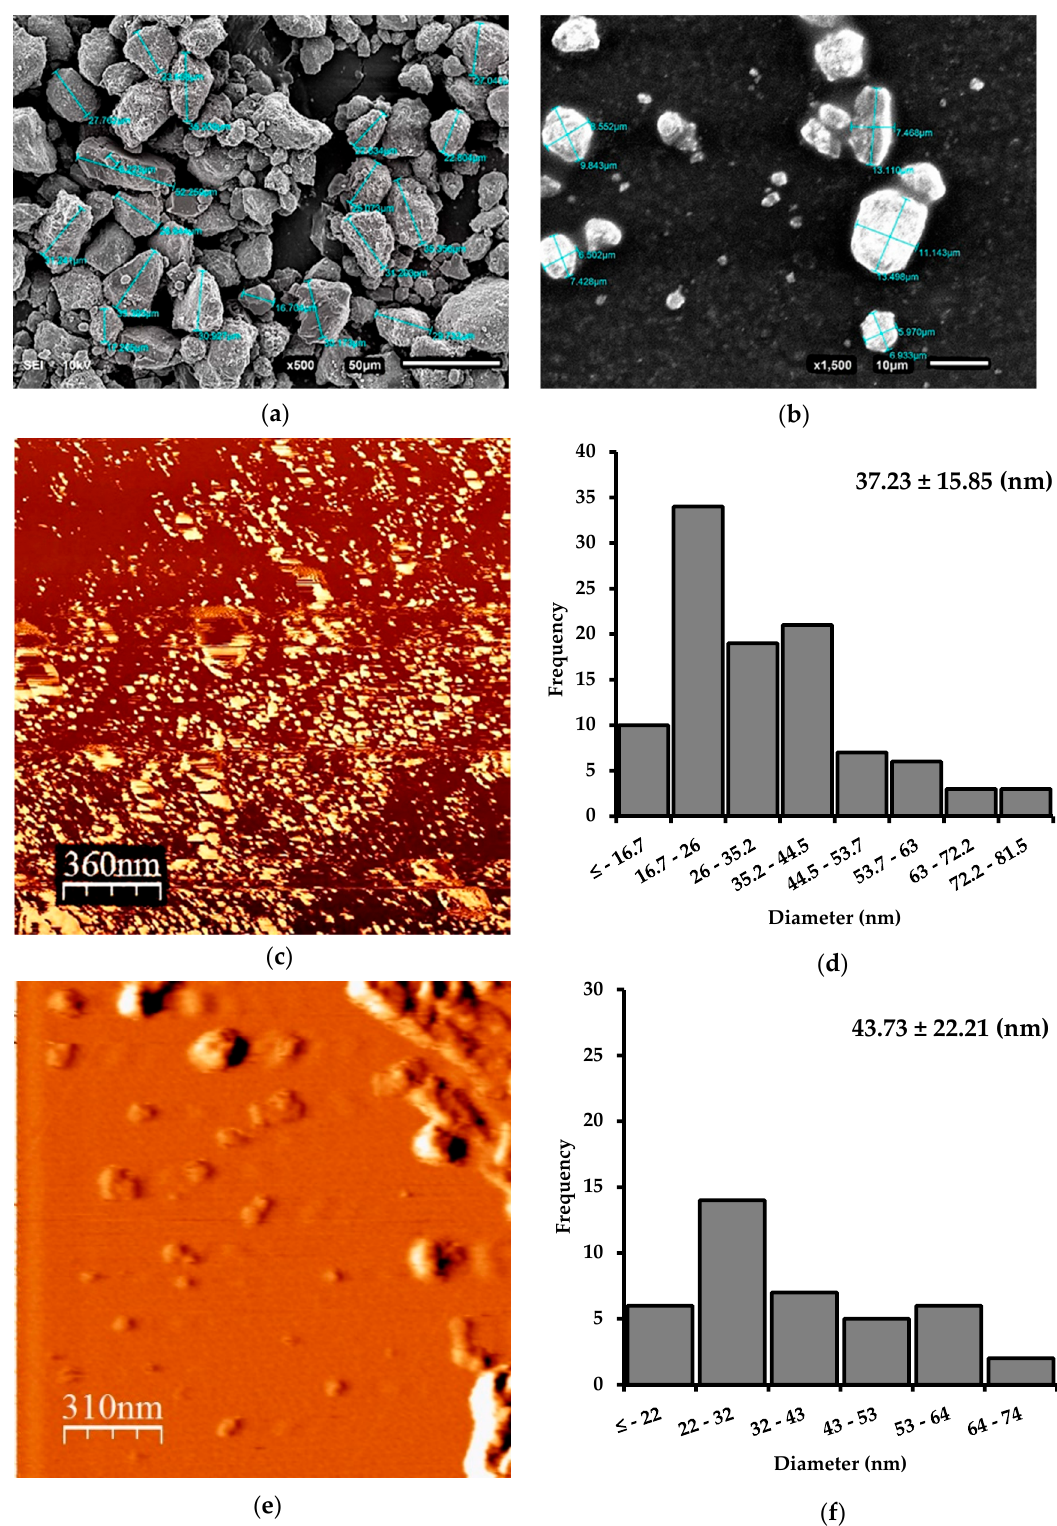
Figure 1. SEM and AFM images of natural zeolite particles after di ff erent size reduction processes. ( a ) SEM. Zeolite microparticles after the ball mill process; ( b ) SEM. Zeolite microparticles after the grinding process in a SUPER MASSCOLLOIDER; ( c ) AFM. nZ after the microfluidization process; ( d ) nZ histogram. ( e ) AFM. nZH-Cu; ( f ) nZH-Cu